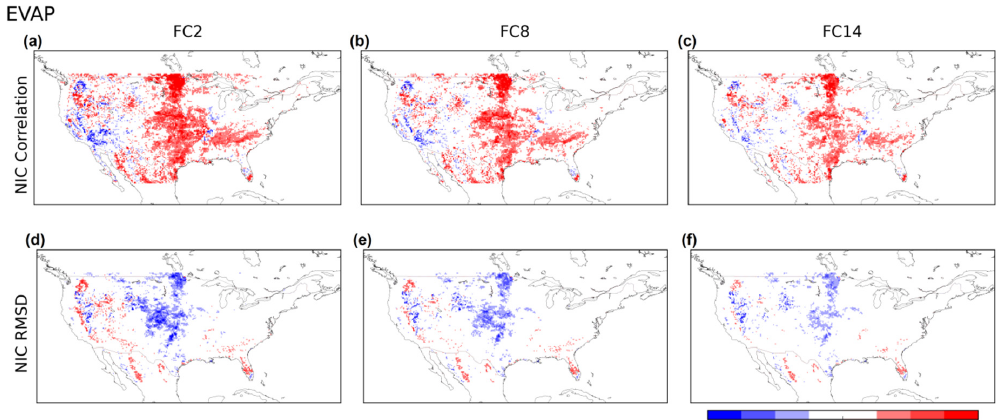
Figure 9. Same as Figure 7, except for simulated ET and Atmosphere ‐ Land Exchange Inverse (ALEXI) ET. Spatial patterns of persistence of SEKF impact on simulated SSM as compared to CGLS SSM as forecast lead time increases. Upper row of maps shows NIC R values at FC2 ( a ), FC8 ( b ), and FC14 ( c ). Bottom row of maps ( d – f ) is the NIC RMSD values at the same forecast lead times. Note that red color for correlation is improvement from assimilation, whereas blue is improvement for RMSD.